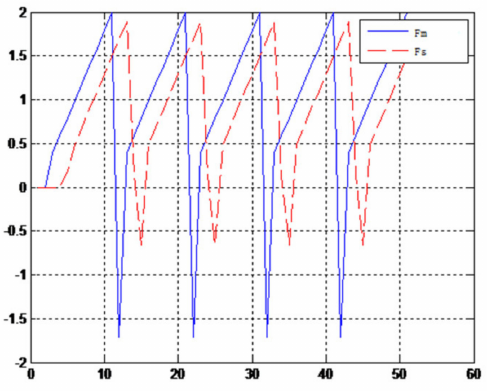
Figure 24. Force feedback wave along x axis. (Constant time delay, solid ball). When the object is an elastic ball, the elastic coefficient of the object is smaller, and the parameter of B is smaller. The elastic ball selected in this experiment is shown in Figure 25. The force feedback wave of the haptic device along the x axis when Baxter is grasping the elastic ball is shown in Figures 26 and 27 (robust control